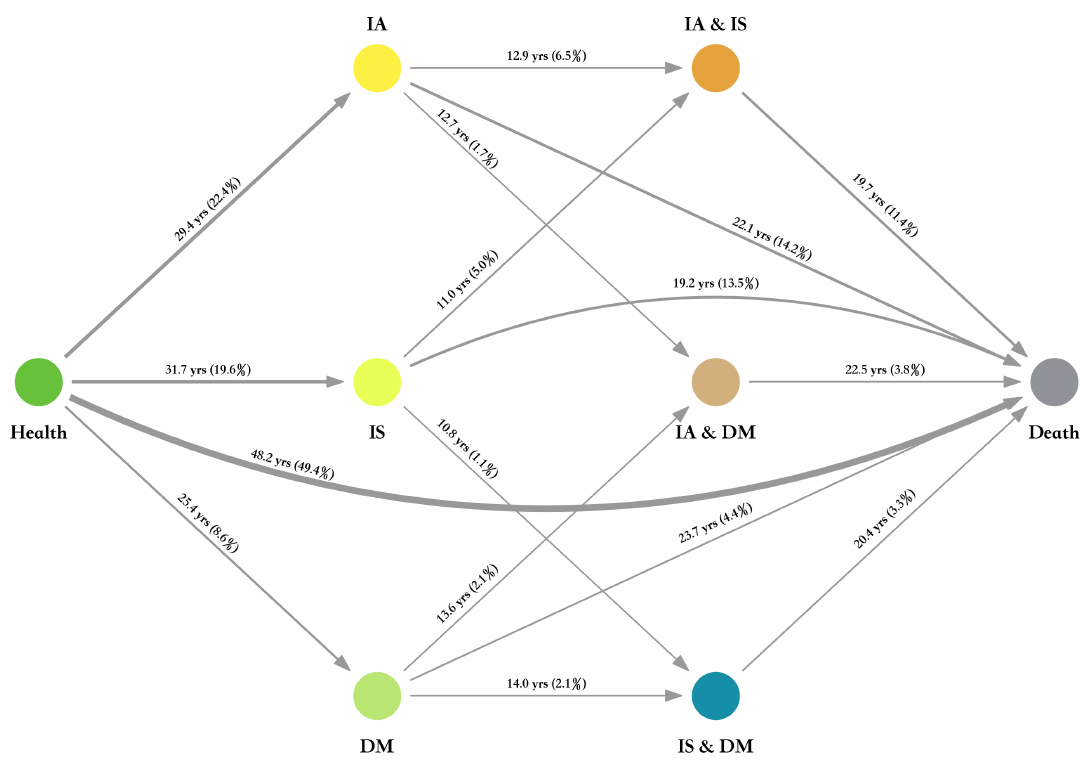
Figure 10. Overall disease metastasis of 5-year interval group.